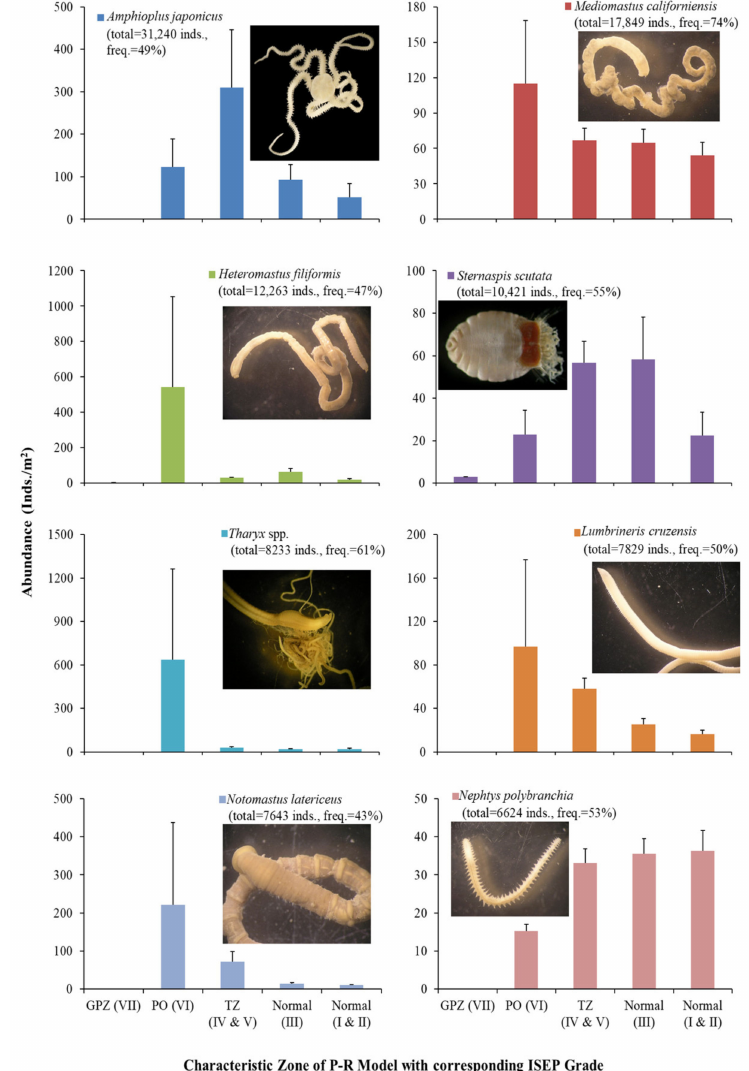
Figure 7. Variations in the abundance of dominant species along the characteristic zones. The data are shown for each dominant species of high abundance. ISEP grades are shown on the x -axis from low quality (grade VII) to high quality (grade I) to allow the direct comparison with the P-R model. Note that TZ = transitory zone, PO = peak of opportunists, and GPZ = grossly polluted zone. The patterns of the dominant species, in terms of biomass, were not significantly differ- ent in their monotonic or unimodal responses along the characteristic zones. However, the biomass of most species generally increased toward the normal zone (Figure 8). The repre- sentative species were spatangoid echinoderm, Echinocardium cordatum , pinnotherid crab, Xenophthalmus pinnotheroides , polychaetes, Sternaspis scutata , Lumbrineris heteropoda , tellinid bivalves, and Nitidotellina hokkaidoensis . In contrast, the biomass maxima of ophiuroids, A. japonicus , polychaetes, H. filiformis , and Glycera chirori coincided with their abundance peaks and appeared in the TZ/PO zones (Figure